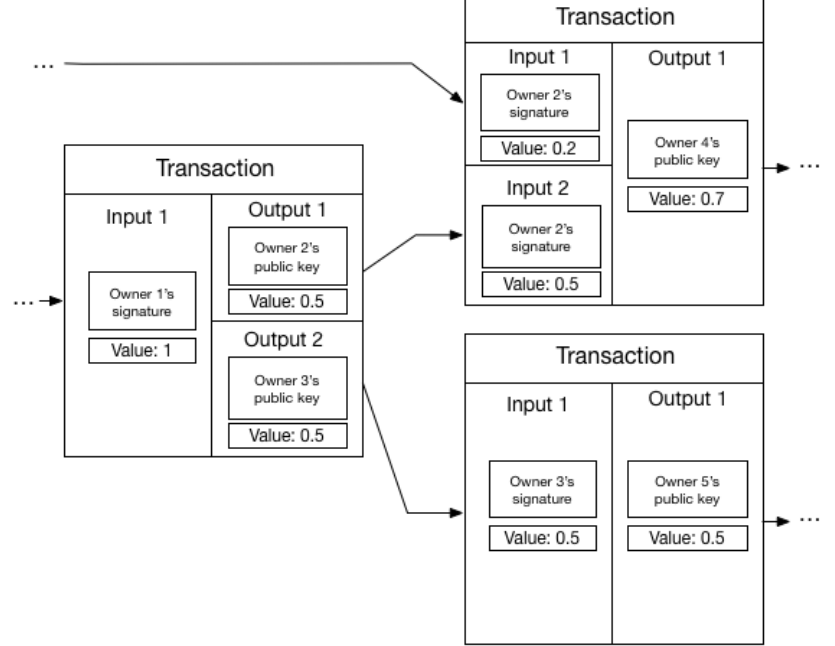
Figure 1. Section of a transaction